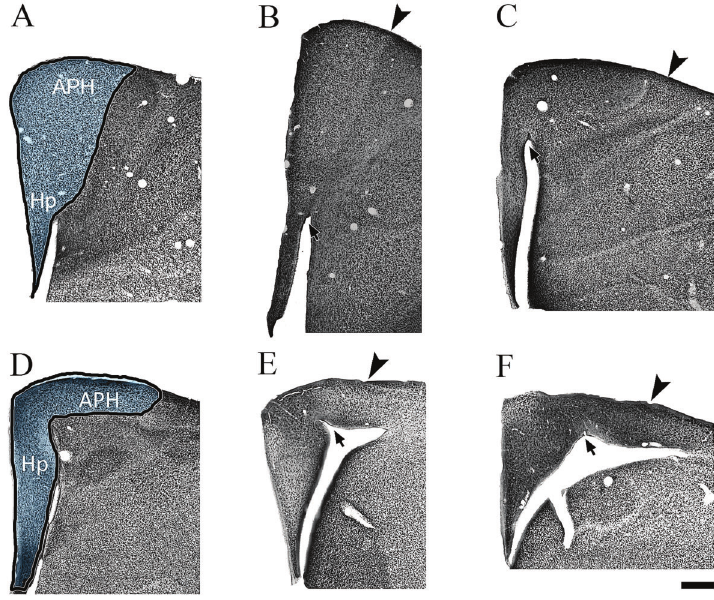
( C. pusilla : 17.75 ± 3.90 vs A. macularia : 9.15 ± 0.83, two-tailed t -test, P=0.039). The difference in the telencepha-